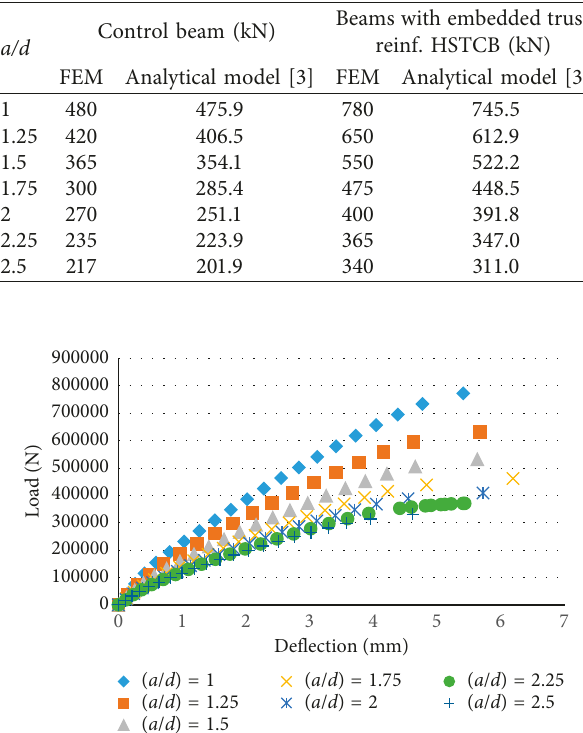
Figure 10: Load-deflection relationship for RC beams using em- bedded steel truss.